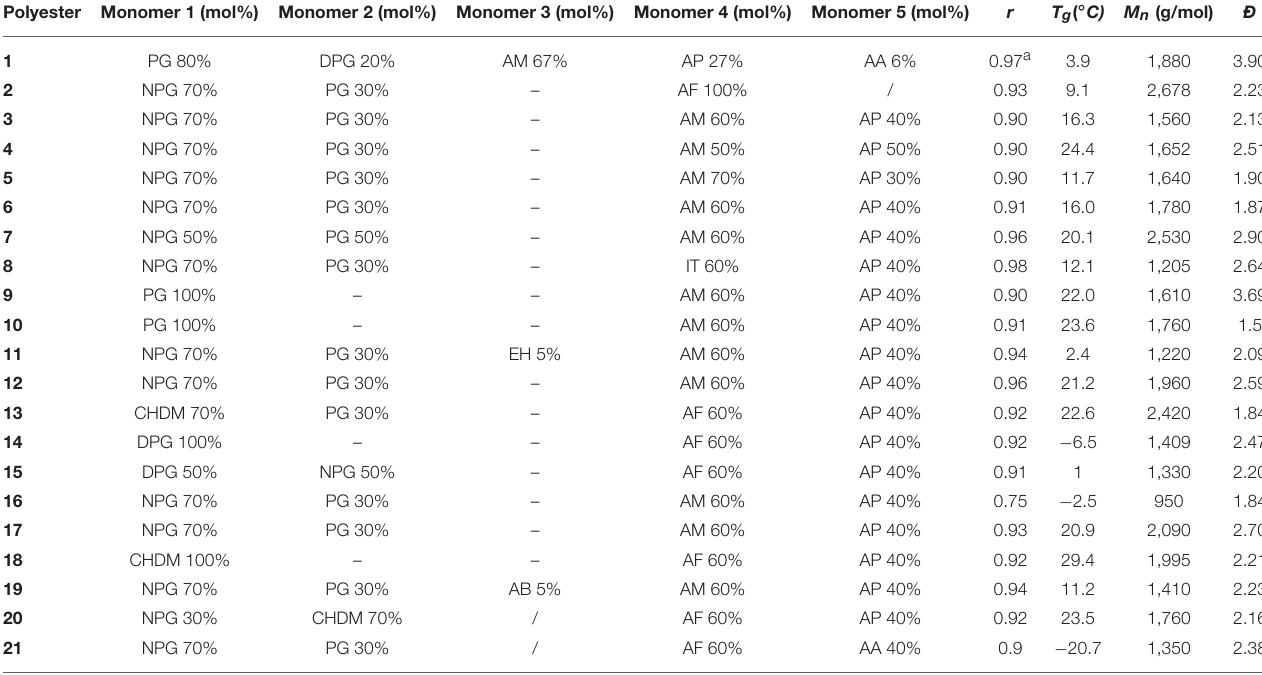
TABLE 1 | Structures of the unsaturated polyesters